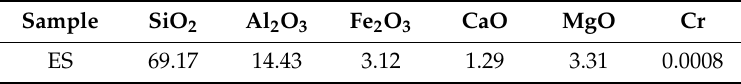
Table 1. Chemical composition of expansive soil (wt %).